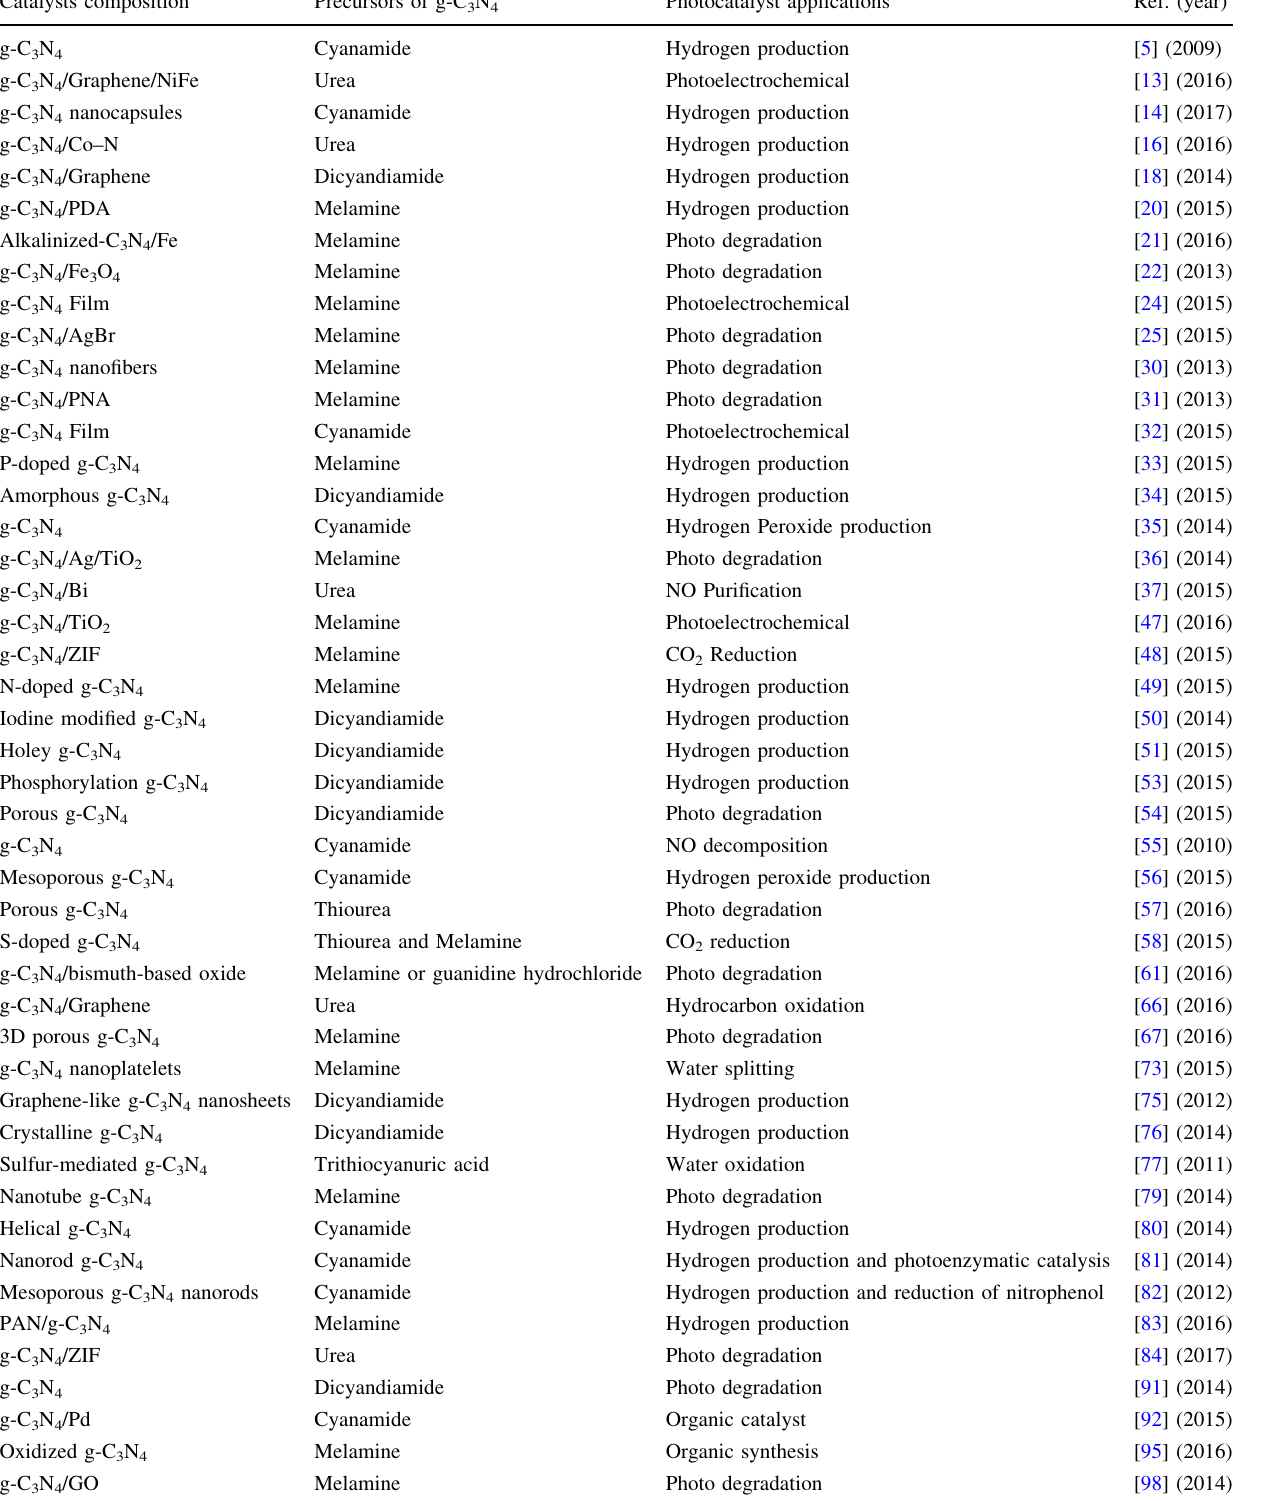
Table 1 Recent reports on g-C 3 N 4 -based